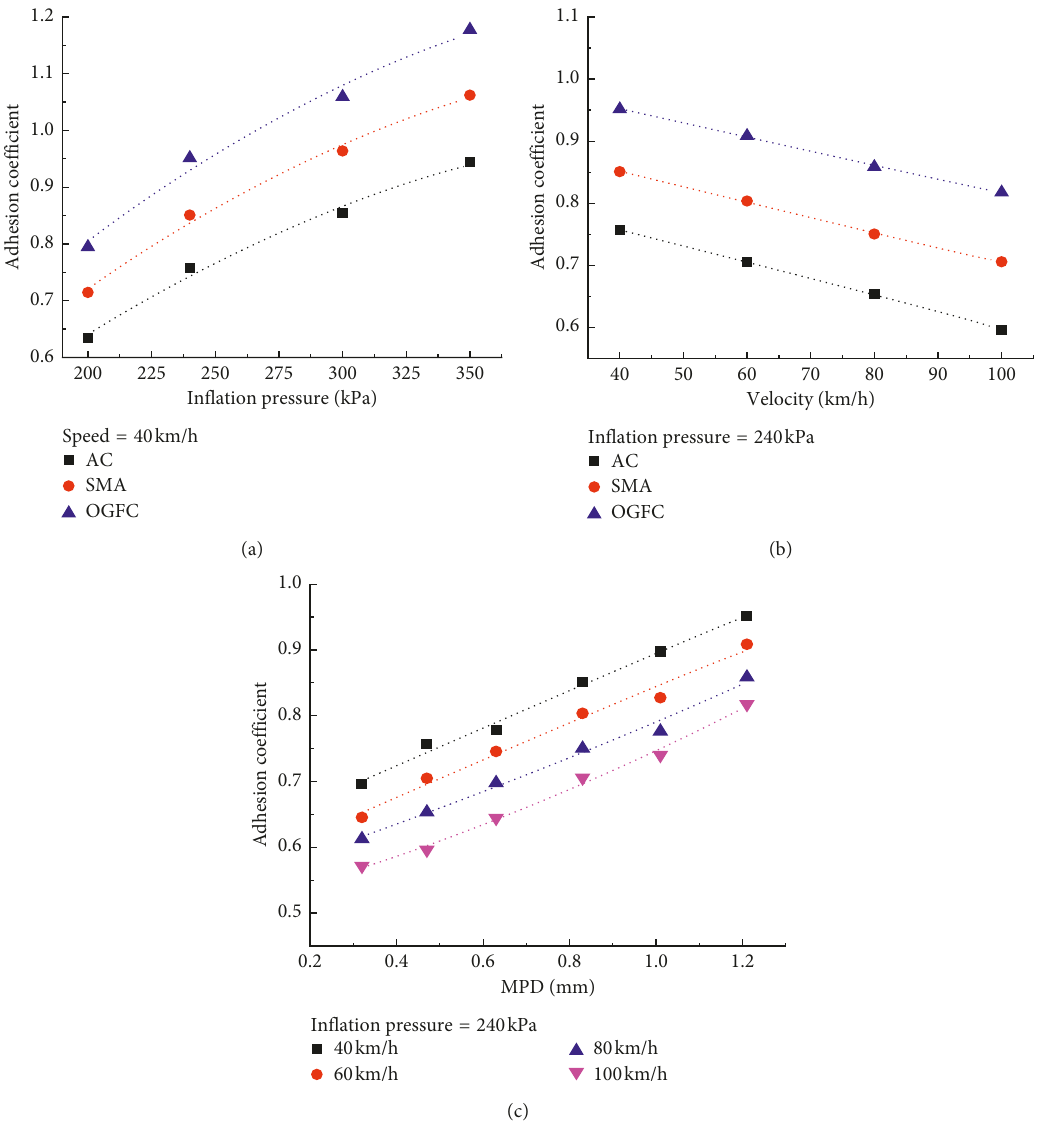
Figure 9: Influential factors analysis of the adhesion coefficient: (a) internal inflation pressure; (b) velocity; (c) MPD